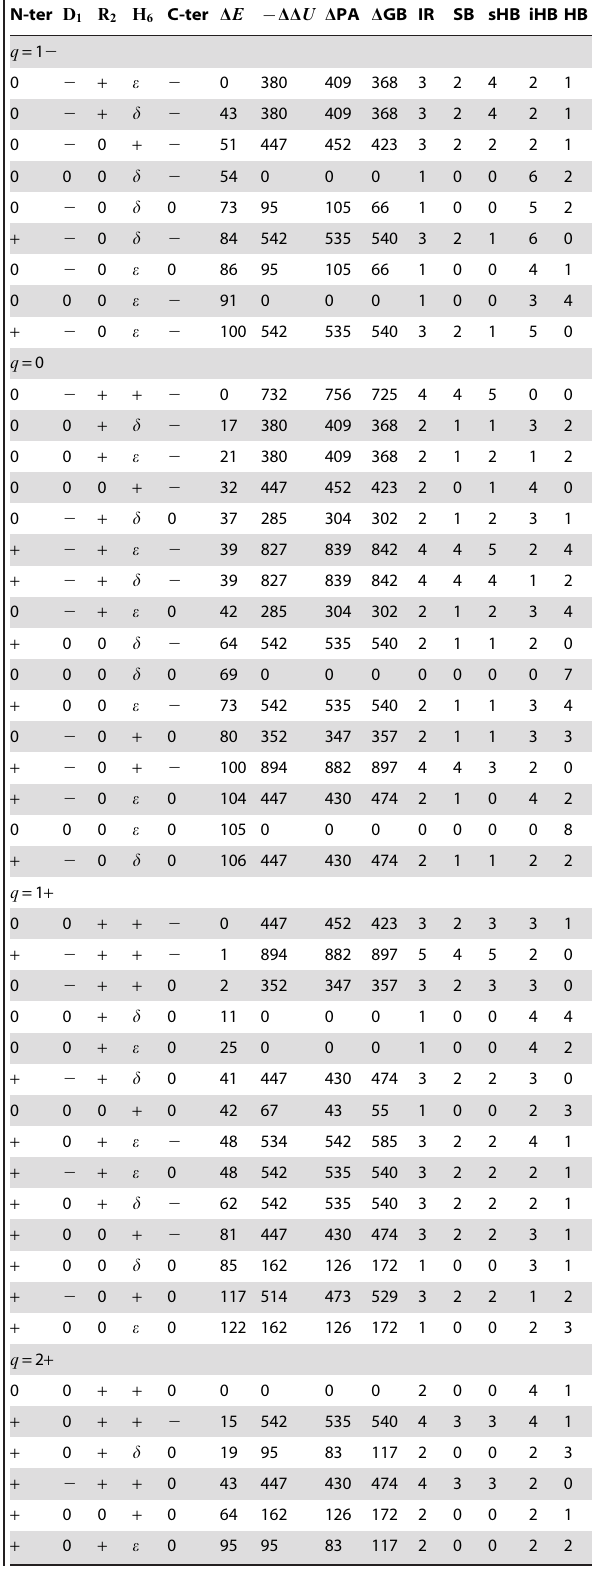
Table 2. Energetics and structural parameters for the lowest- energy conformers of angiotensin II